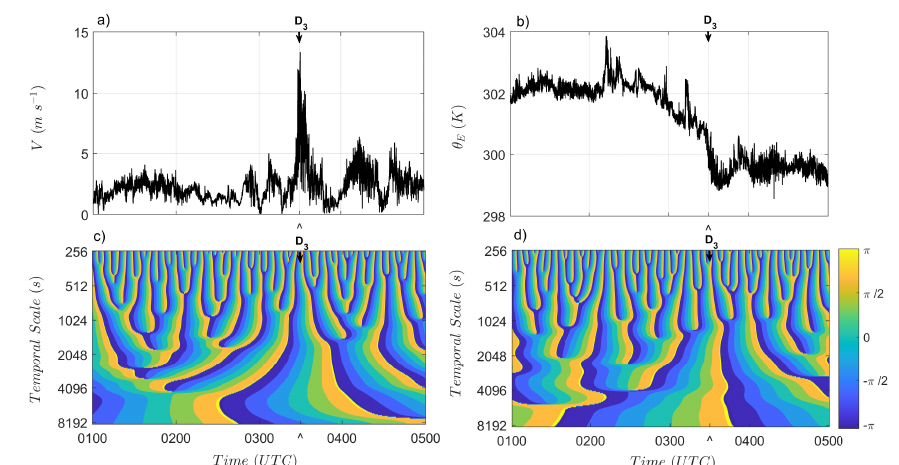
Figure 4. Time series measured at 48 m in 13 April 2014: ( a ) Horizontal wind speed ( V ); ( b ) equivalent potential temperature ( θ E ). Phase of the Morlet wavelet: ( c ) of V and ( d ) θ E . The arrows D 3 indicate the main phase singularity (during EP).